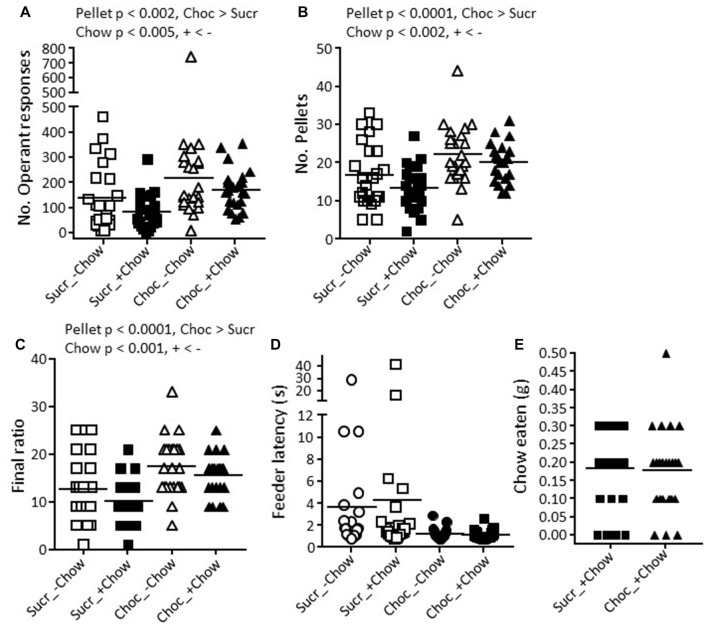
Effects of provision of a chow pellet and of sweet pellet type on behavior in the EVT in non-manipulated mice in Experiment 2. Each mouse was tested under each condition, first with sucrose (Sucr) and then with chocolate (Choc) pellets, and by counterbalancing with respect to whether they were tested first with (+) or without (−) a chow pellet. (A) Number of operant responses. (B) Number of sucrose pellets earned. (C) Final ratio attained. (D) Mean latency to collect the pellet from the feeder. Graphs are scatter plots and mean values per group. Significant statistical effects indicated were obtained with 2 × 2 repeated measures ANOVA with within-subject factors of reward and chow pellet. (E) In the +Chow conditions, scatter plots and overall means for the weight of chow eaten during the test session.